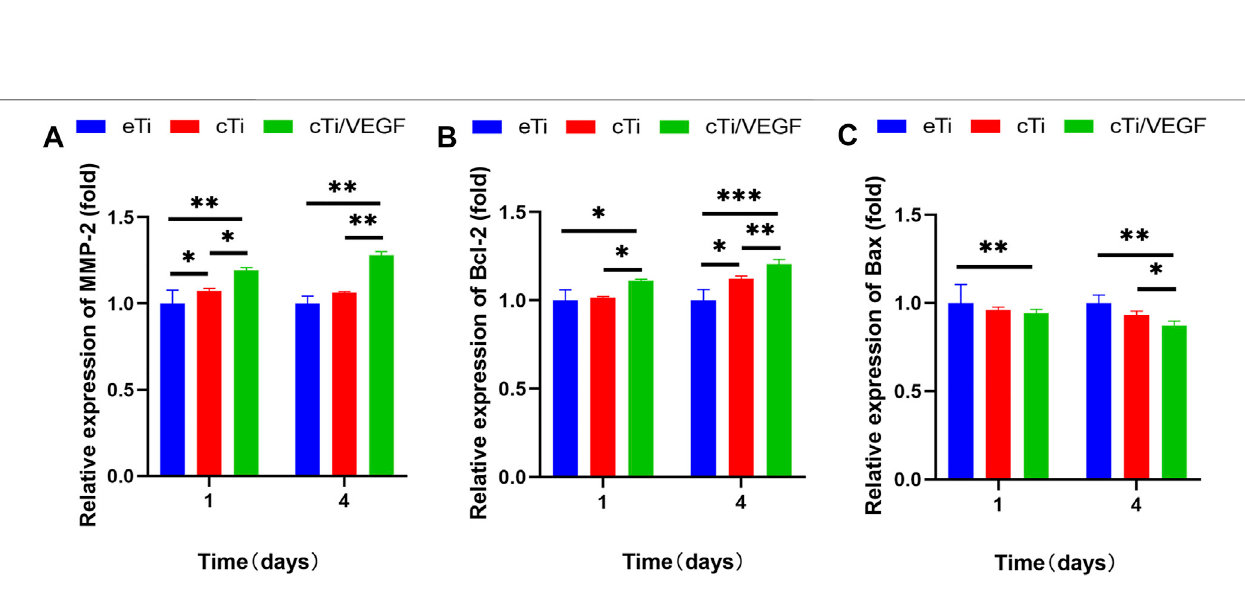
Frontiers in Bioengineering and Biotechnology |